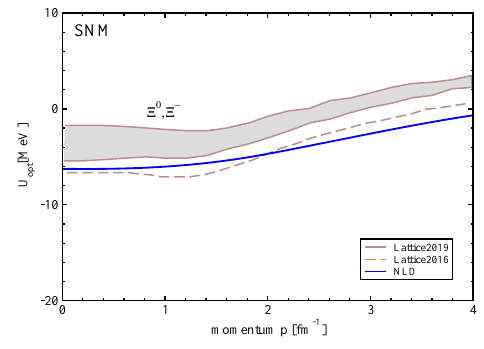
Figure 5. Optical potentials for hyperons (as indicated) versus their momentum for pure neutron matter. Solid curves with symbols indicate the NLD calculations while pure curves without symbols are the microscopic χ -EFT results from [2]. Green pairs (circles-solid for NLD and solid for χ -EFT) refer to low density of p F = 1 fm − 1 , red pairs (diamonds-solid for NLD and dashed for χ -EFT) refer to saturation density of p F = 1 . 35 fm − 1 and blue pairs (triangles-solid for NLD and dashed-dotted for χ - EFT) refer to a density of p F = 1 . 53 fm − 1 .